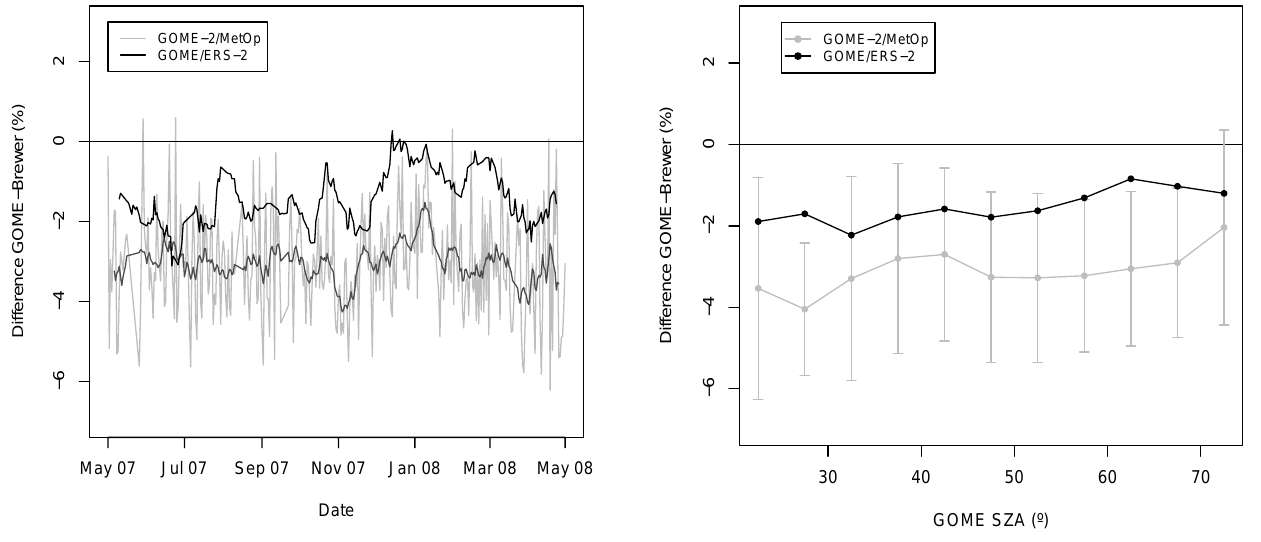
Fig. 2. Dependence of GOME-Brewer relative differences with re- spect to the GOME solar zenith angle (SZA) for the “Iberian Penin- sula”